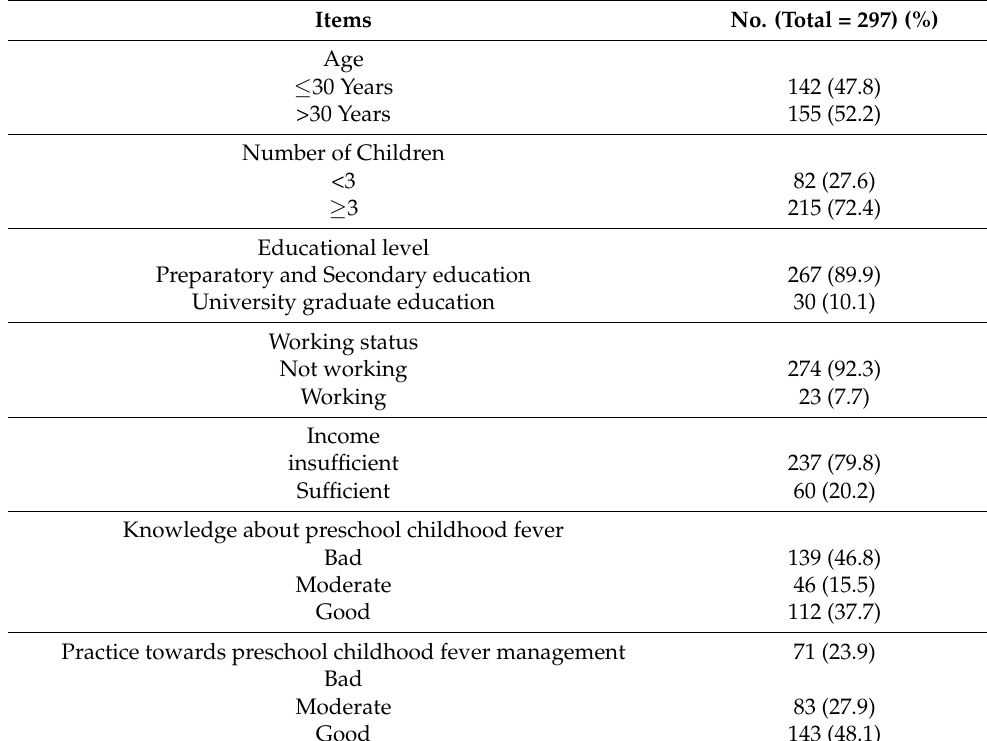
Table 1. Sociodemographic characteristics of mothers and their knowledge and management practices of preschool childhood fever.